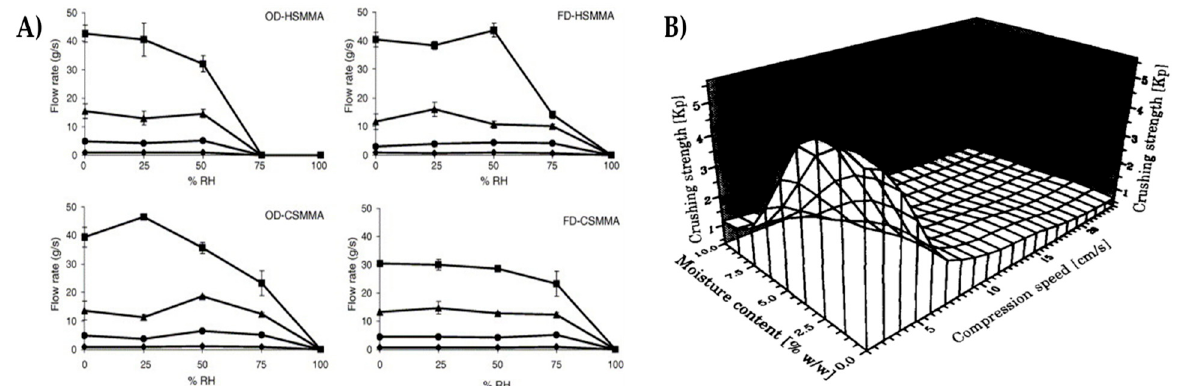
Figure 7. ( A ) Flow rate (g/s) vs relative humidity percentage (RH) of the different methacrylate copolymers using stainless-steel funnels of 20 mm ( ■ ), 15 mm ( ▴ ), 10 mm (•). and 5 mm ( ♦ ) holes. Error bars represent the standard deviation, ( B ) Correlation between crushing strength, compression speed, and moisture content for 400 mg ibuprofen tablets. Reprinted with permission from [49] and [55], respectively.